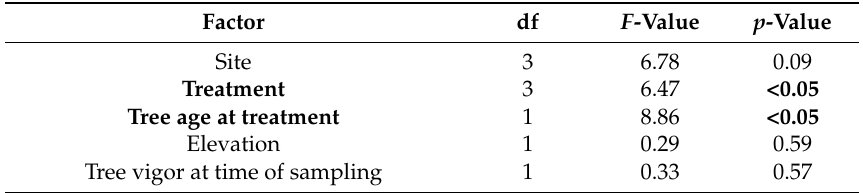
Table 5. Analysis of covariance results for the growth ratio (GR) model based on all sample trees and variables collected from all plots (df = degrees of freedom; bolded variables significant at 0.05 level).